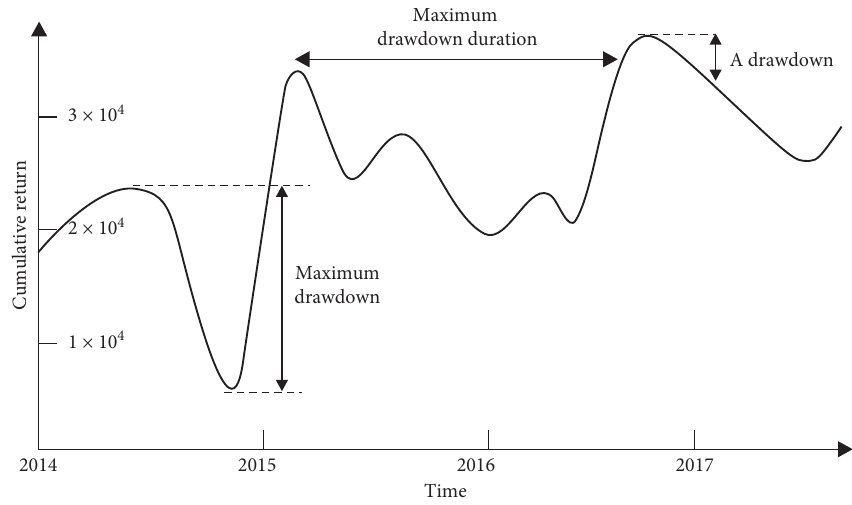
Figure 4: Graphical representation of maximum drawdown